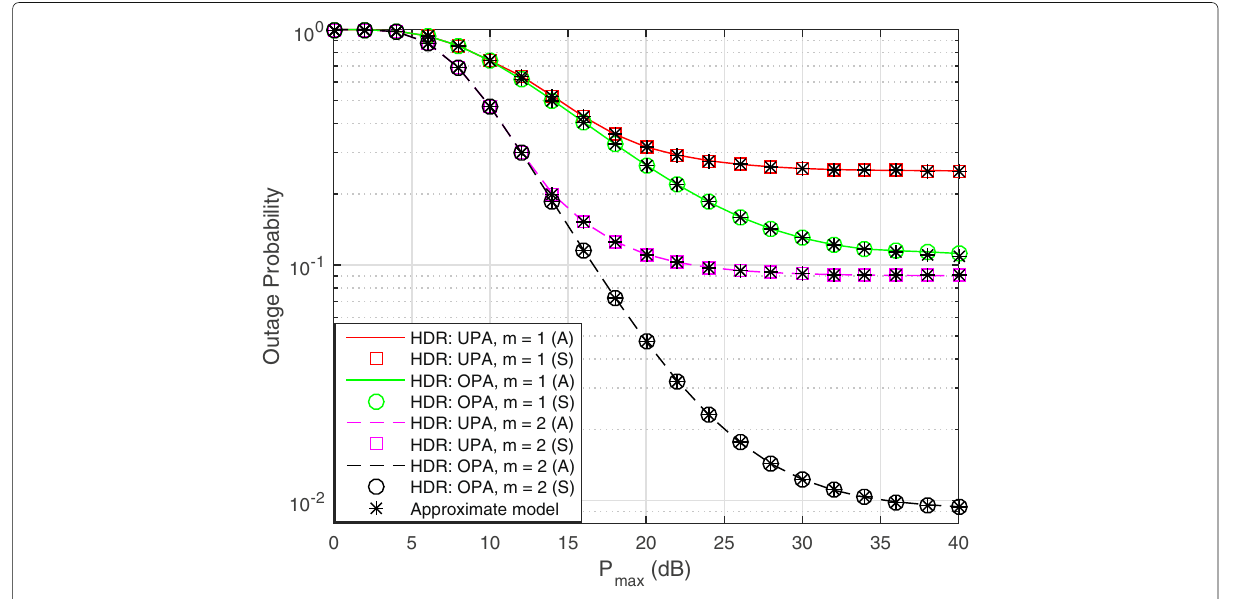
Fig. 4 Outage probability of four-hop HDR system vs P max under UPA and OPA, for different values of m : N = 3